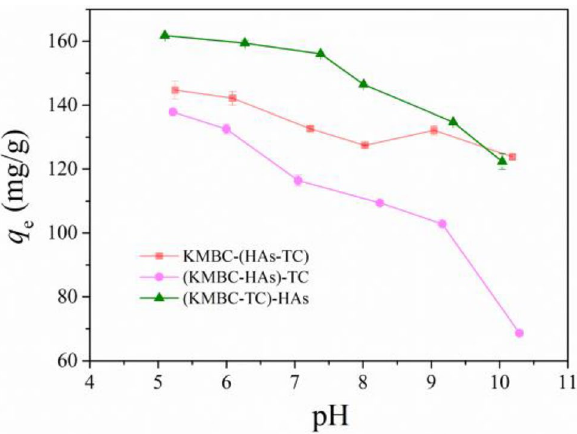
Figure 7. Effects of addition sequences of dissolved HAs, TC and KMBC. C 0(TC) = 50 mg/L, C 0(HAs) = 5 mg/L, m / V = 0.1 g/L, t = 26 h, T = 25